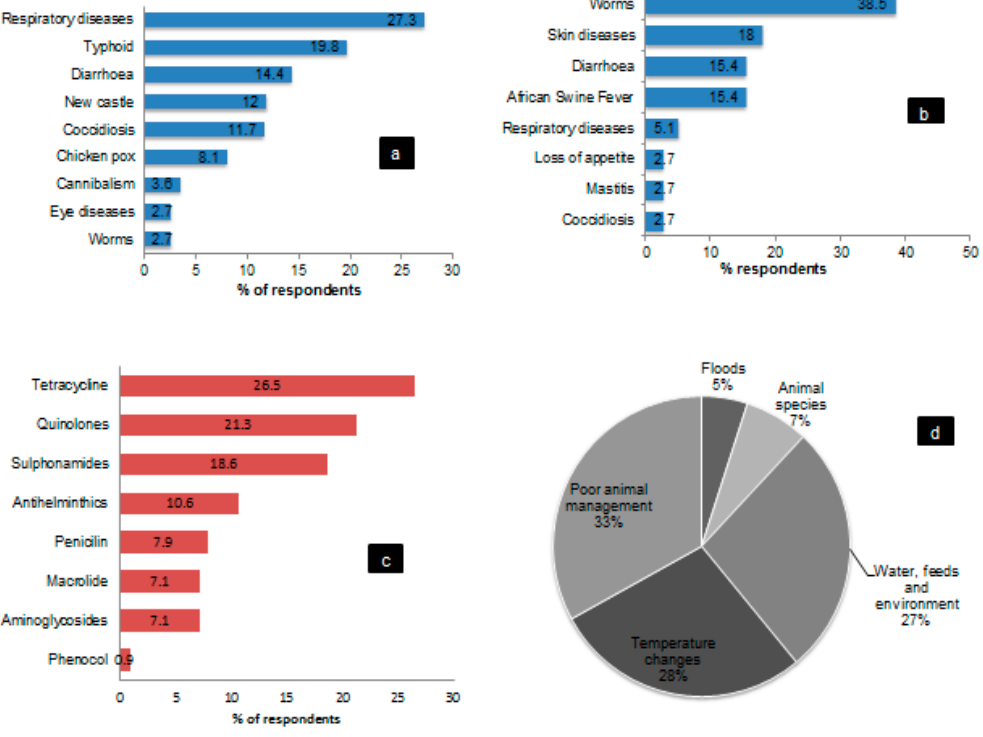
Figure 1. Respondent’s perception of the diseases affecting poultry and domestic pigs ( a ) and ( b ), classes of therapeutics used ( c ) and ( d ) the reason for a disease outbreak in the study